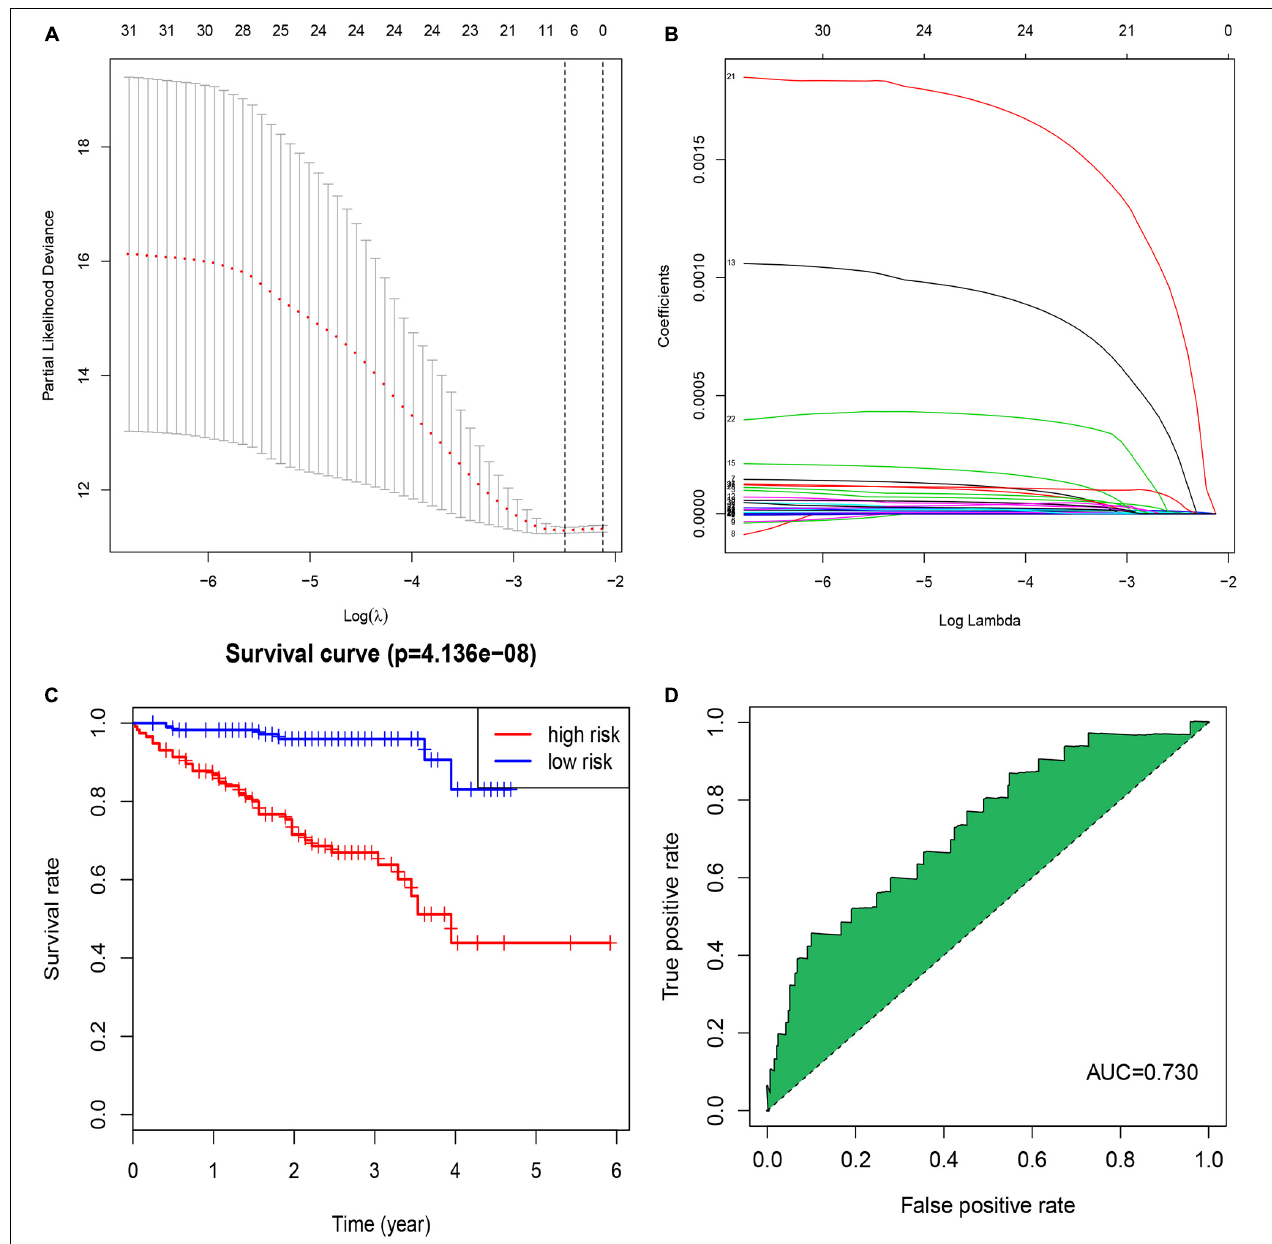
FIGURE 1 | Identification of a signature of seven immune-related lncRNAs. (A) The penalization coefficient λ in the LASSO model was tuned using 10-fold cross-validation and the minimum criterion. AUC metrics ( y -axis) were plotted against log( λ ) (bottom x -axis). The top x-axis indicates the number of predictors for the given log ( λ ). Red dots indicate the average AUC for each model at the given λ , and vertical bars through the red dots show the upper and lower values of the AUC, according to the 10-fold cross-validation. The black dotted line on the left defines the optimal λ (where the model provides its best fit to the data). For the optimal λ , seven immune-related lncRNAs with non-zero coefficients were selected. (B) LASSO coefficient profiles of the 32 immune-related lncRNAs. (C) The K-M survival curve shows the results of survival analysis for the signature of seven immune-related lncRNAs in TCGA-OV dataset. (D) ROC curve analysis of the signature of seven immune-related lncRNAs in TCGA-OV